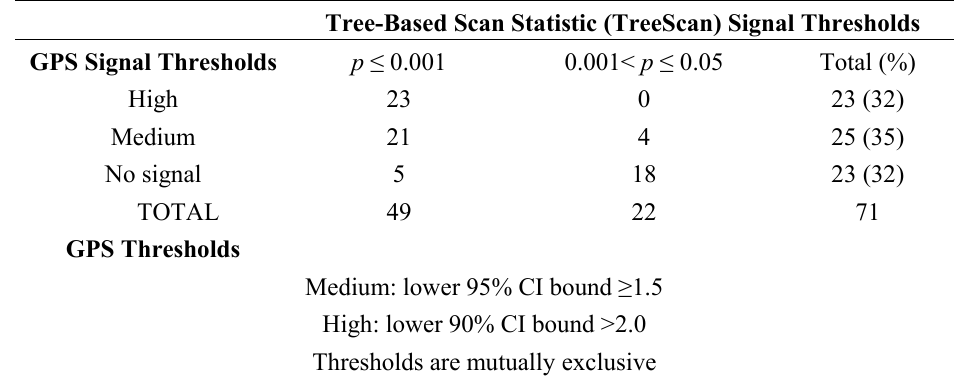
Table 4. Comparison of all GPS and TreeScan signals across the four drugs studied by threshold. Tree-Based Scan Statistic (TreeScan) Signal